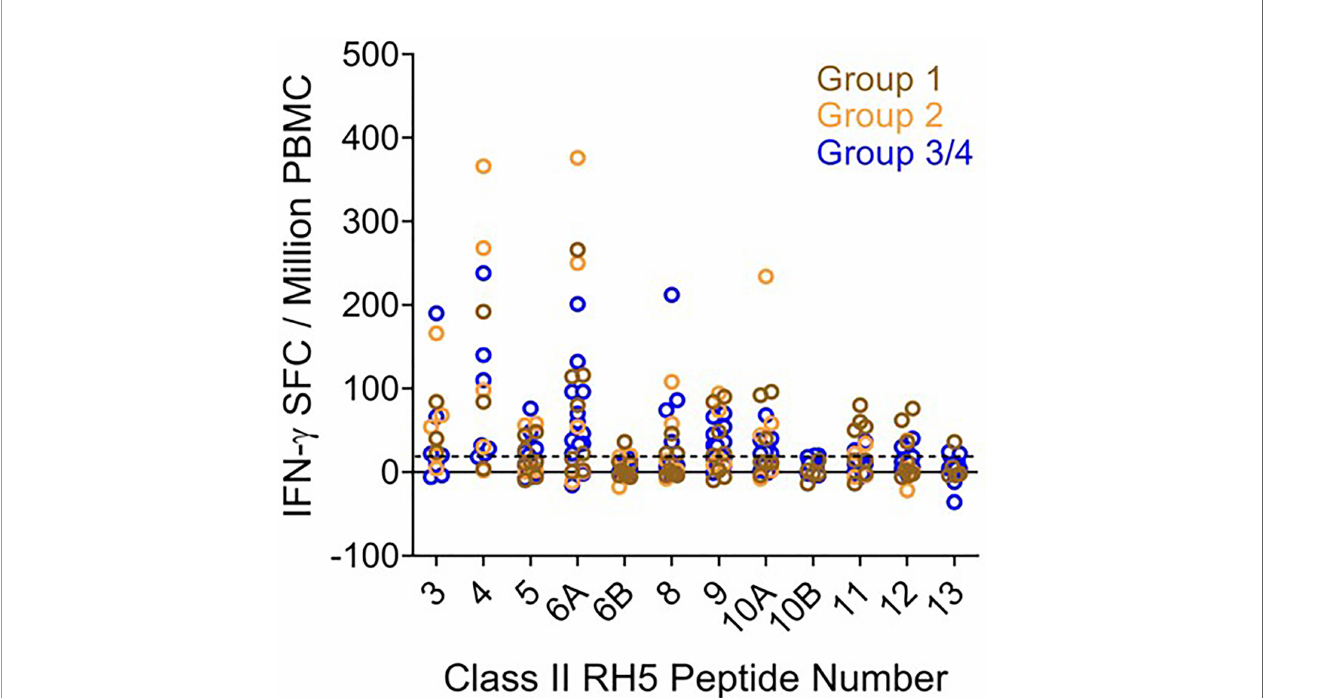
FIGURE 6 | Ex vivo IFN- g recall responses to predicted RH5 class II epitope clusters with HLA-matched VAC063 vaccinee donor PBMCs demonstrate the highest T cell responses in clusters found in the N-terminal region of RH5. Individual data points (colored circles) represent vaccinee samples from different dosing regimen groups ( Table S20 ). Peptide numbers indicate the predicted class II cluster number (numbered sequentially from the N- to C-terminus). The established positivity cut-off (dotted line) was ≥ 20 SFC/million